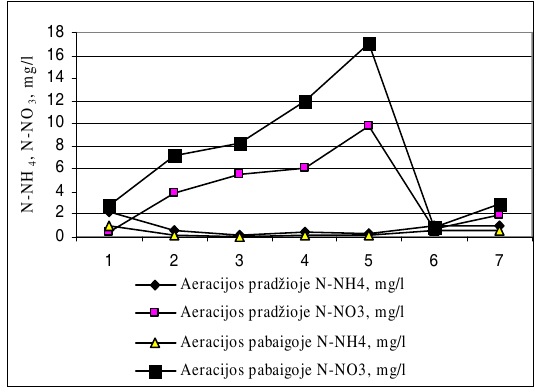
Fig 8. Concentration change of ammonium nitrogen and nitrates in the second aeration tank in the beginning and at the end of aeration at aeration rate of 180, 120 min, and reduced aeration rate of 120 min